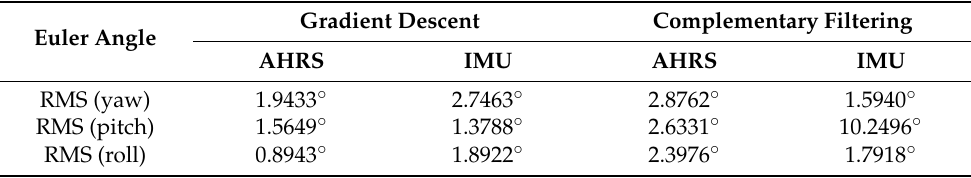
Table 2. RMS of different attitude solution